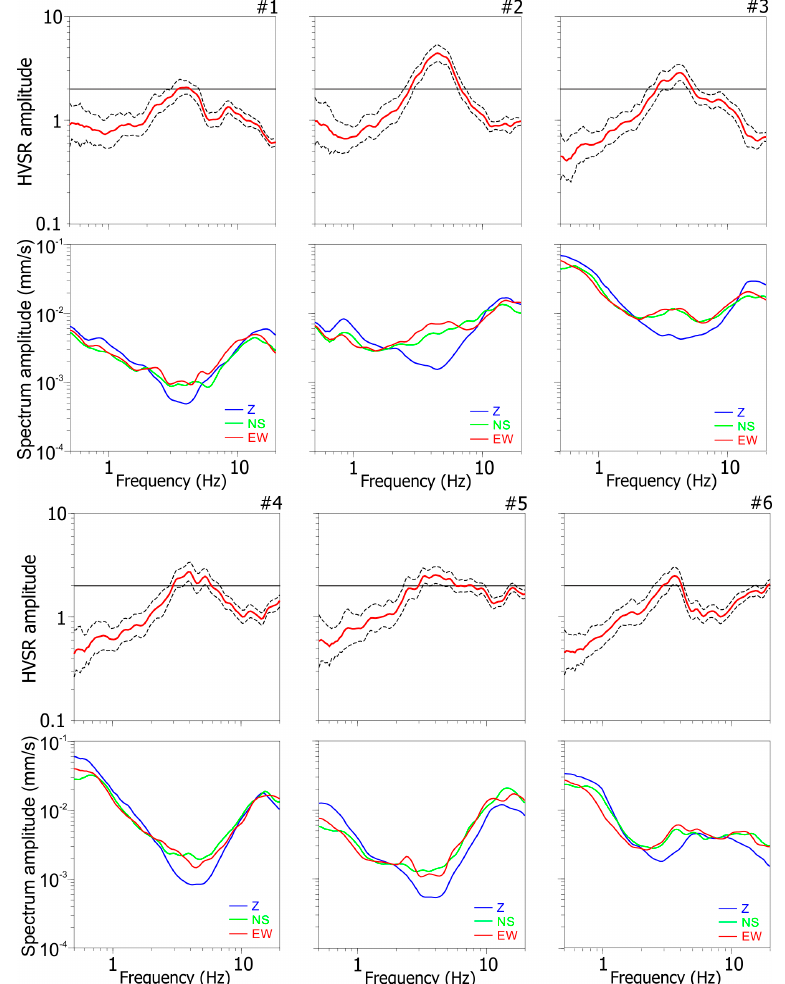
Figure 8. HVSR plots and corresponding Fourier spectra obtained from ambient noise recordings performed outside the Benedettini monastery (see Figure 1b for the locations).